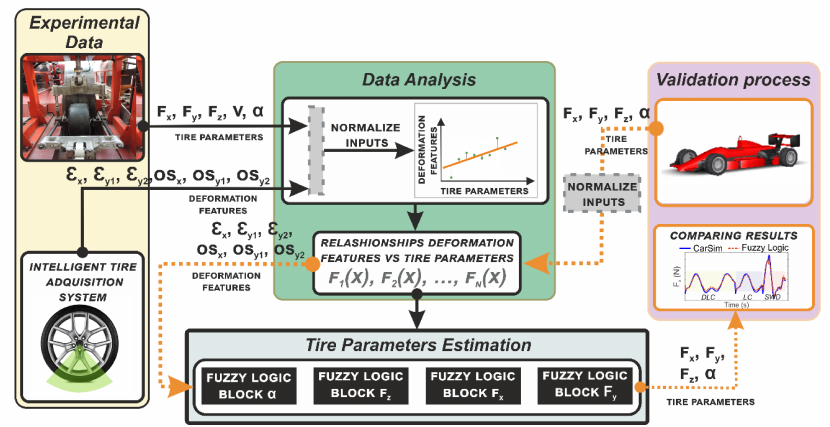
Figure 24. Overview of the methodology presented in [39] to develop the strain-based tire state estimation